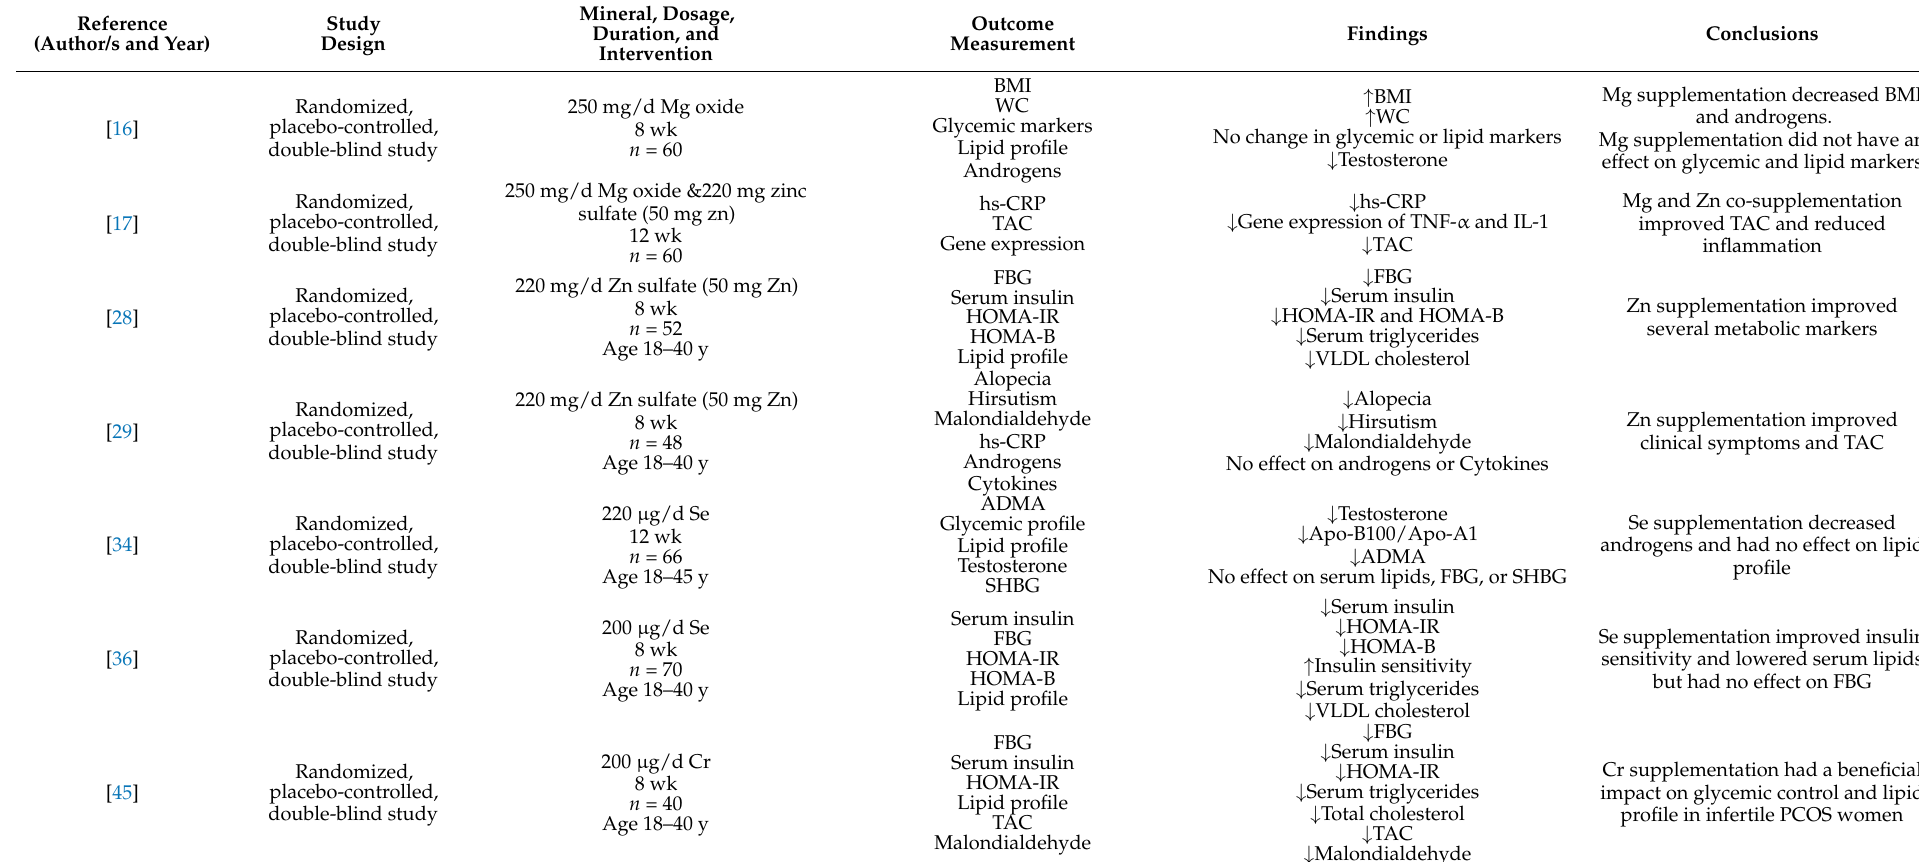
Table 1. Summary of studies that assessed supplementation of magnesium, zinc, selenium, and chromium in women with PCOS phenotype 1